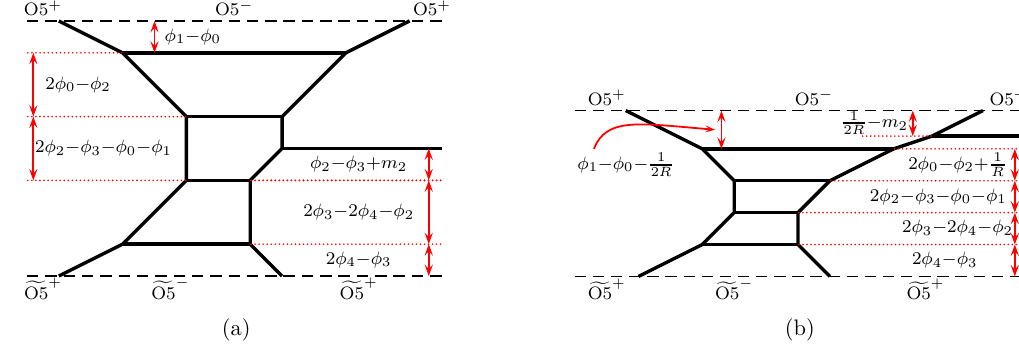
Figure 3. (a) The 5-brane web obtained by applying figure 2(b)–(d) to the bottom part of figure 2(a). (b) Flop transition of